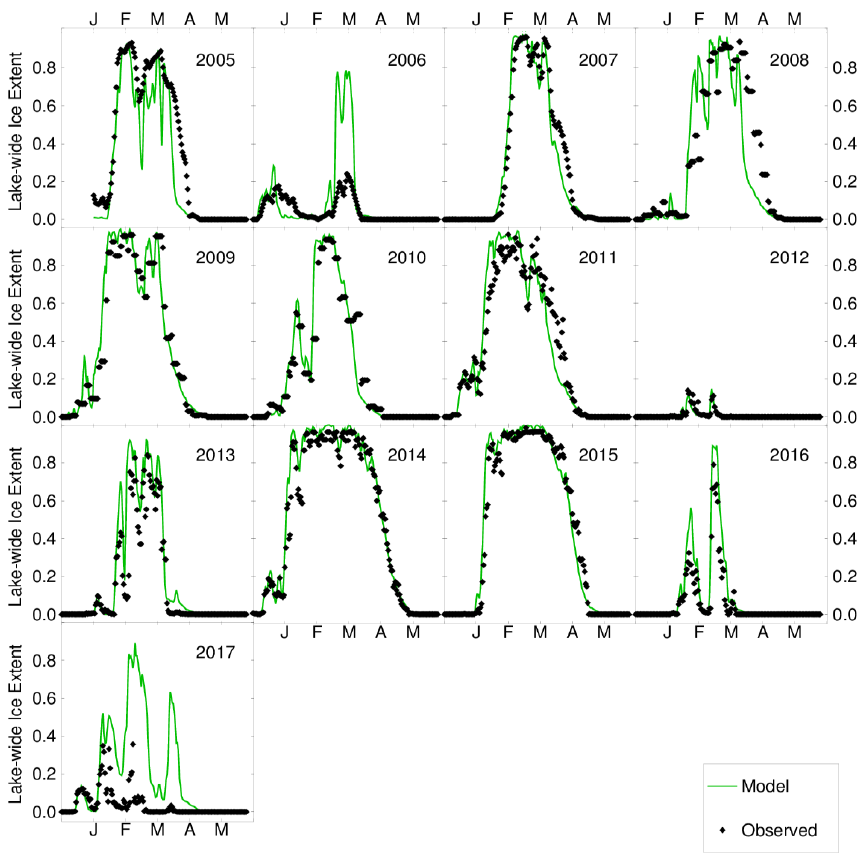
Figure 3. Simulated lake-wide average ice extent for Lake Erie ( green line ) and the ice extent from the NIC ( black dots ). Table 2. Seasonal mean RMSEs [0–1] of simulated lake-wide ice area, ice concentration at pixels, and binary ice cover at pixels. The lake-wide RMSEs are normalized by an area of each lake. The seasonal means are calculated from 1 December in the previous year to 31